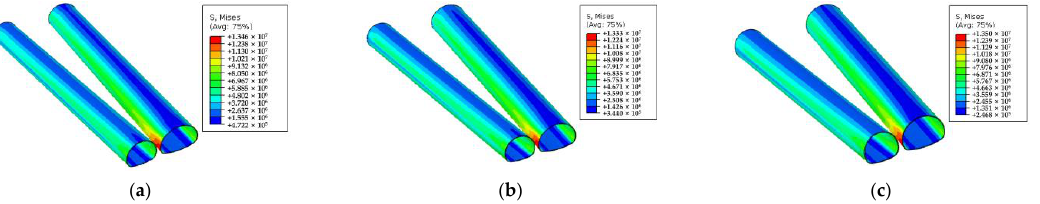
Figure 19. Stress distribution of supporting structure in different footage: ( a ) Footage 3 m; ( b ) Footage 4 m; ( c ) Footage 5 m.